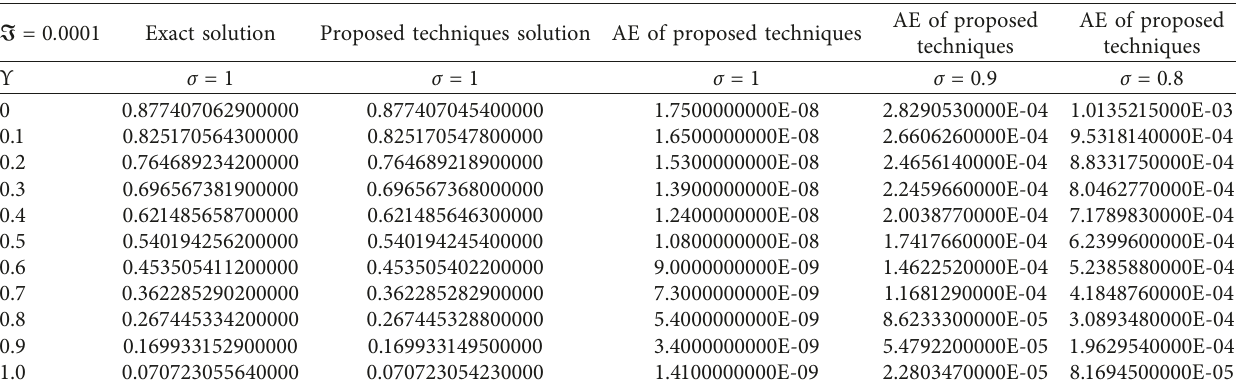
Figure 7: Exact solution, analytical solution, absolute error, and various fractional order solution for φ ( ξ , I ) and ] ( ξ , I ) of problem 4. Table 7: Comparison of the proposed method and exact results with absolute error (AE) at various fractional order for φ ( ξ , I ) and v ( ξ , I ) of problem